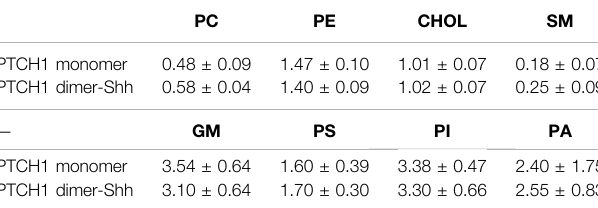
TABLE 1 | The D − E index of the fi rst lipid shell, which is within 0.7 nm of